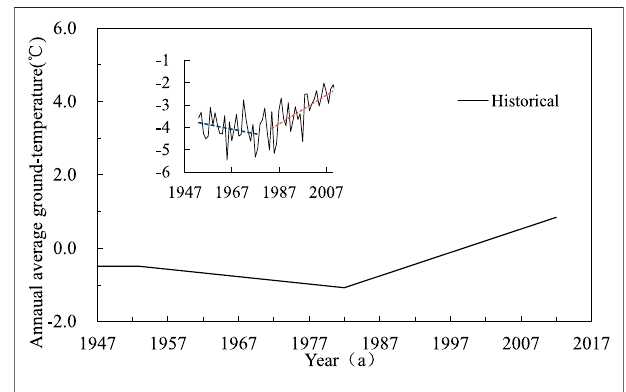
FIGURE 4 | Temperature changes in Madoi from 1947 to